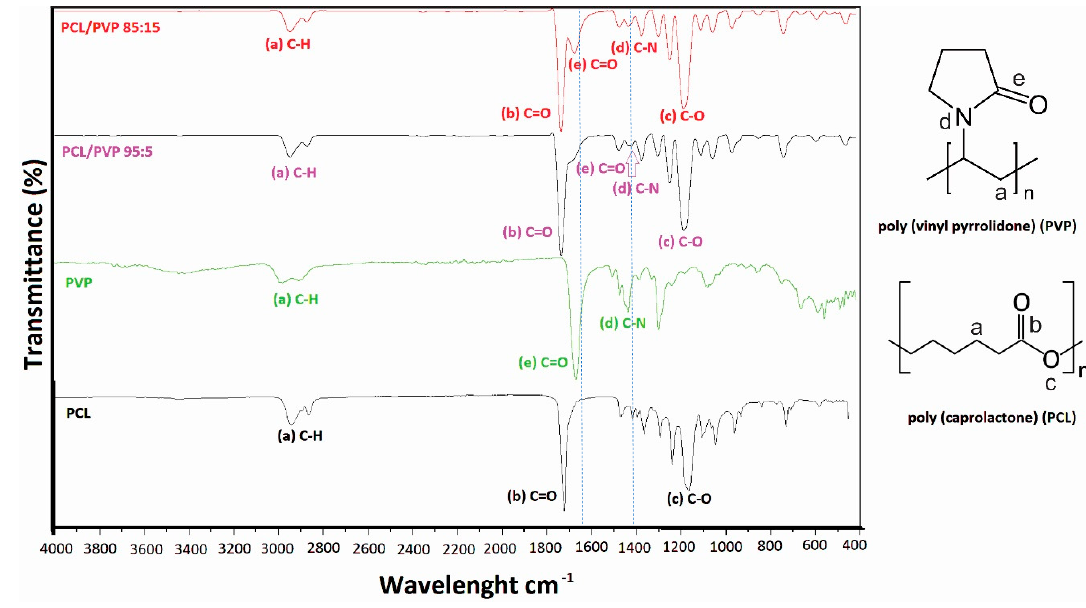
Figure 2. FTIR spectra of PCL, PVP and PCL/PVP fibers.